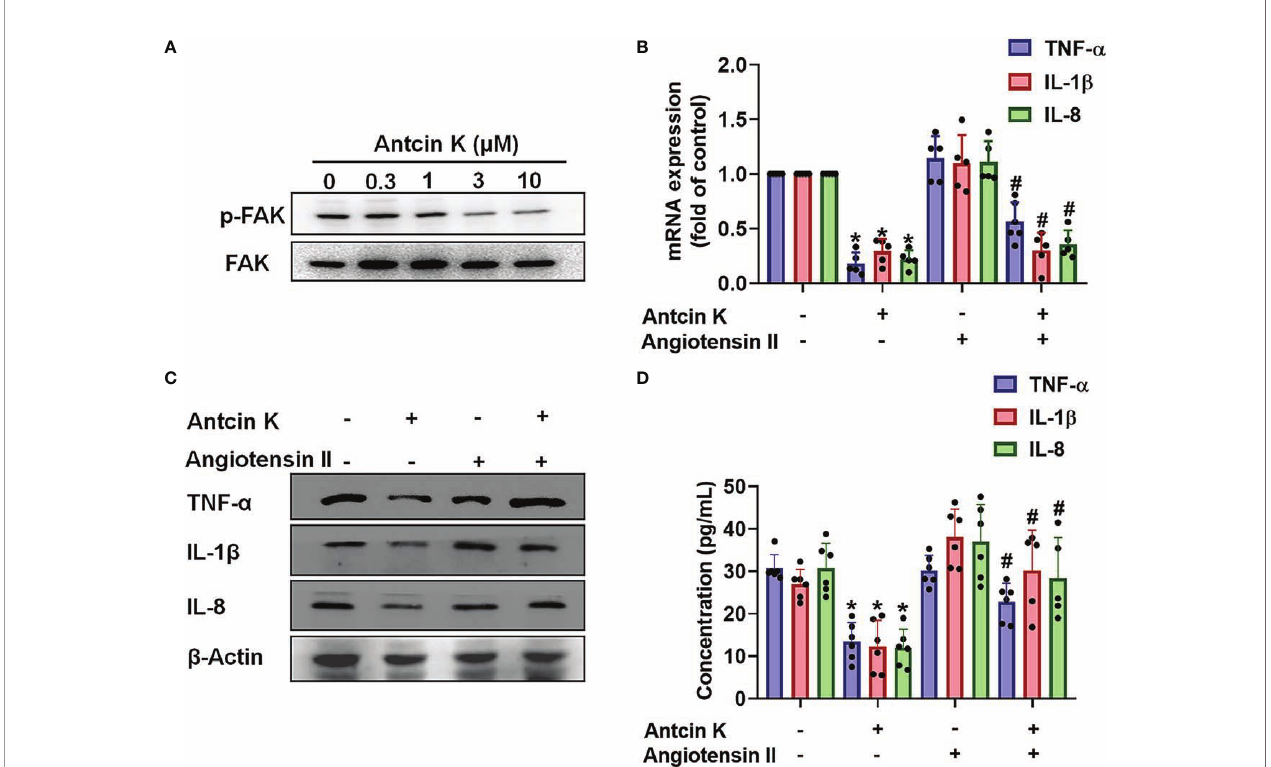
FIGURE 3 | The FAK pathway is involved in Antcin K-induced inhibition of TNF- a , IL-1 b and IL-8 production in RASFs. (A) Cells were treated with Antcin K (0.3, 1, 3 or 10 m M) for 24 h and FAK phosphorylation was examined by Western blot. (B – D) Cells were pretreated with the FAK activator Angiotensin II for 30 min, then treated with Antcin K (10 m M) for 24 h. TNF- a , IL-1 b and IL-8 mRNA expression and protein secretion were examined by qPCR, Western blot and ELISA. Results are expressed as the mean ± SD. * P < 0.05 compared with controls; # P < 0.05 compared with the Antcin K-treated